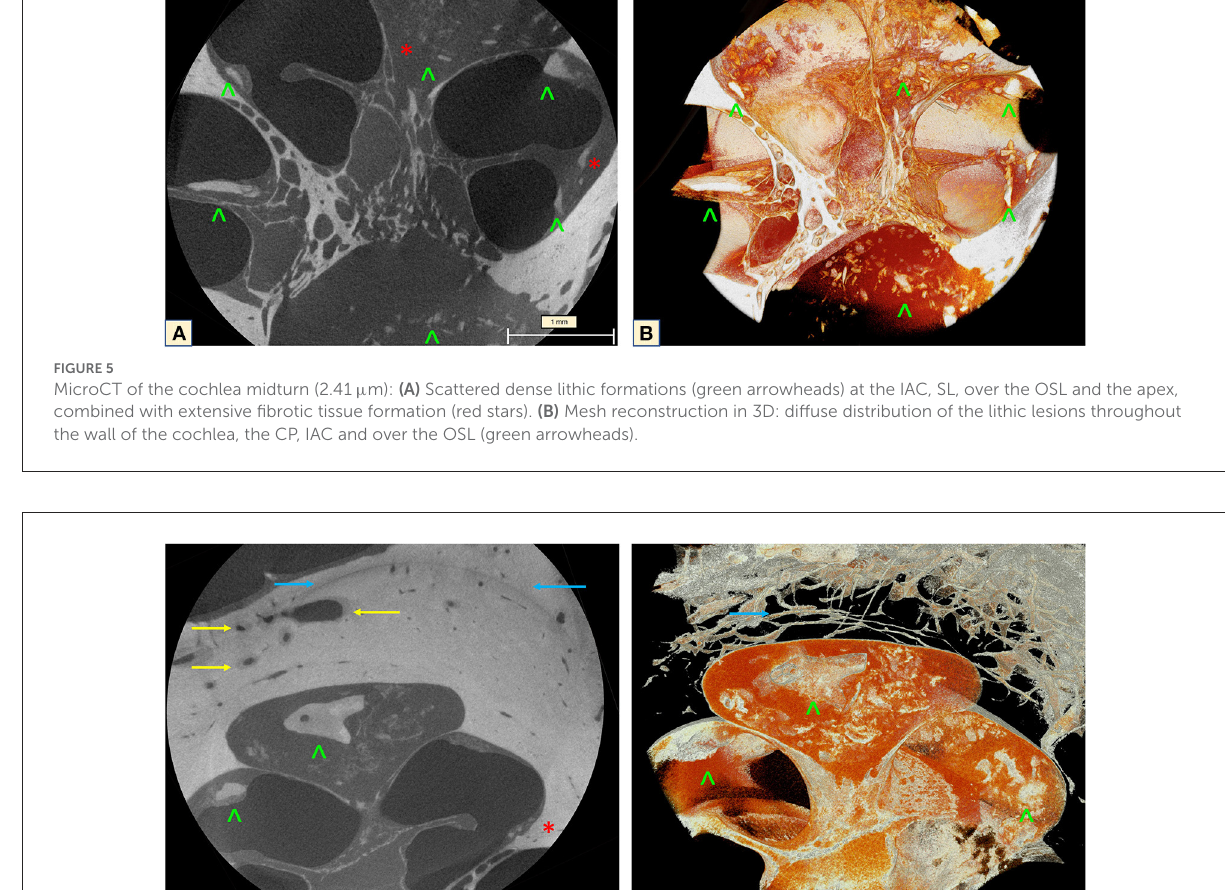
seen over the OSL is localized in the topographic region of the 2kHz (Figure 7A). No CLs were found in other regions of the OSL. The SL and the stria vascularis, which forms the cochlear wall (15), were covered in these CLs, which also affect the CP and the scalas, as observed during imaging